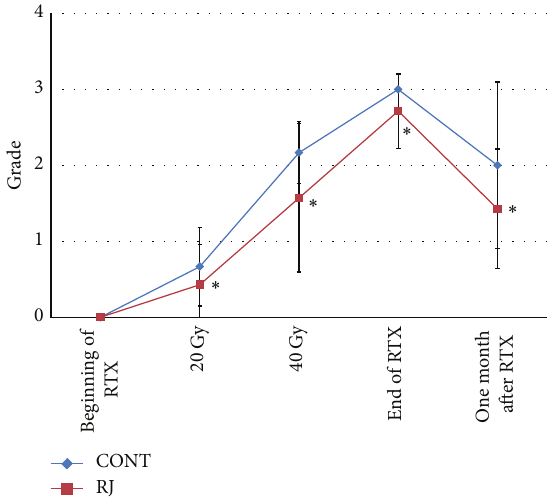
Figure 1: Grades of mucositis. Each data point represents the mean ± SD. Mann-Whitney 𝑈 test: ∗ 𝑃 < 0.001 versus control. RTX: